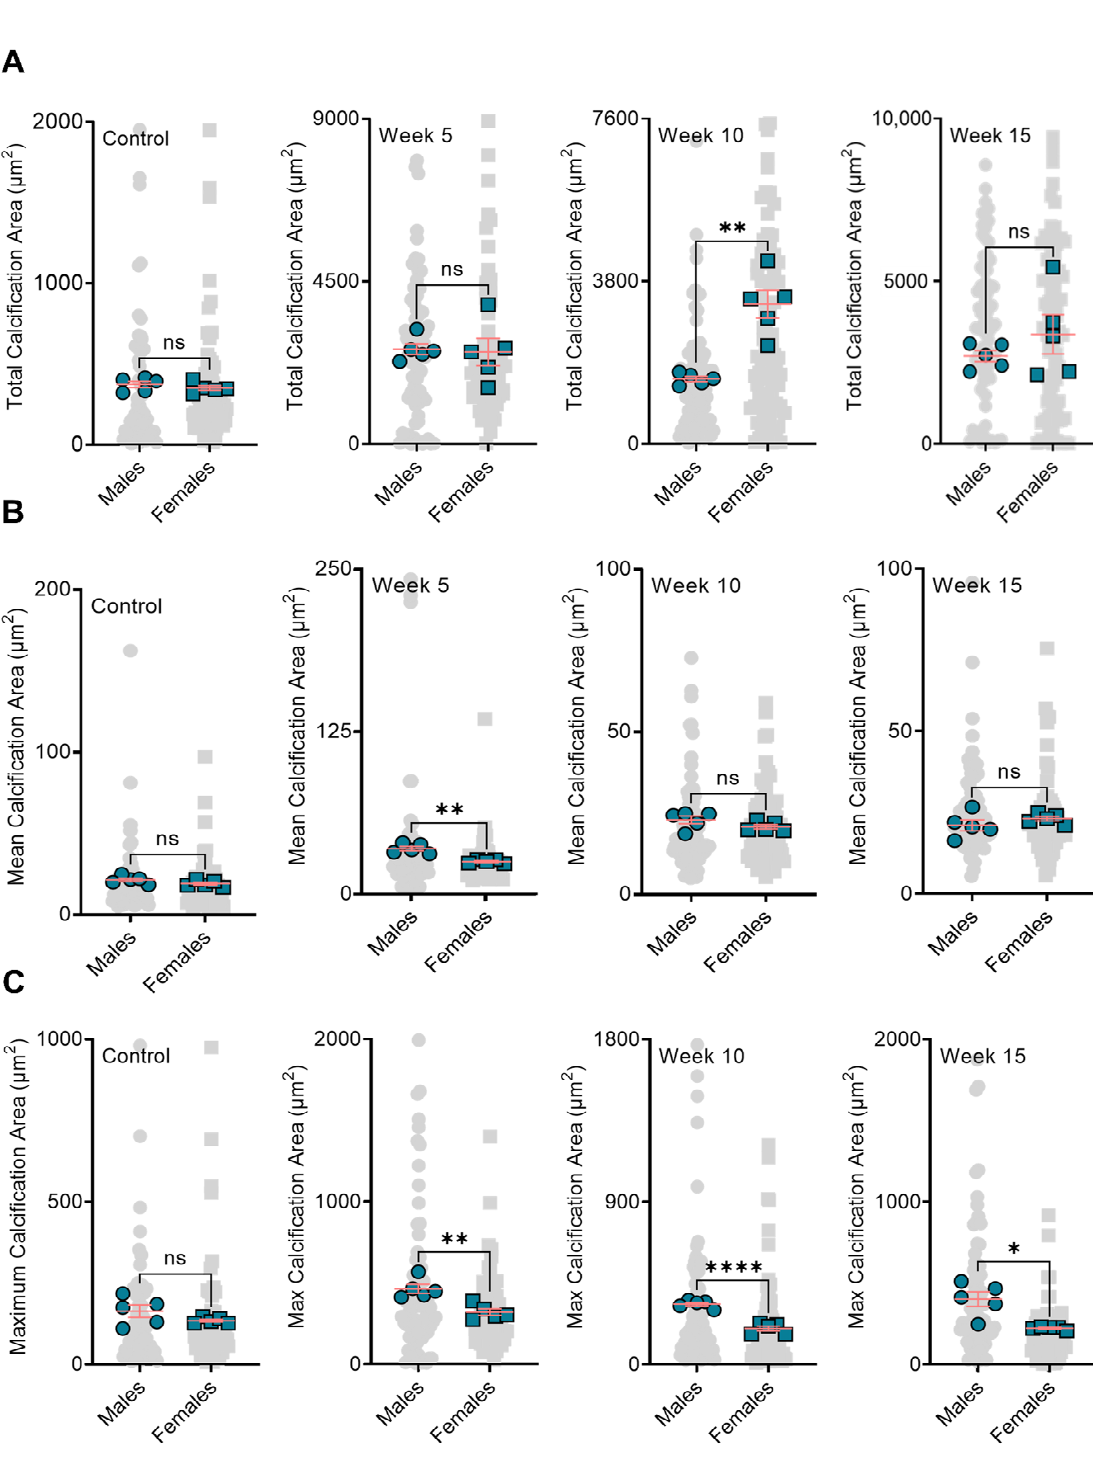
Figure 3. BiP treatment may affect the mineral morphology differently in male and female mouse model. Panel ( A ) is the comparison of total plaque calcification between male and female mice; Panel ( B ) is the comparison of mean calcification area between male and female mice; Panel ( C ) is the comparison of maximum calcification area between male and female mice. Note that gray points ( ● or ■ ) in the background represent technical replications, i.e., all calcifications measured across all mice, and green points ( ● or ■ ) represent the biological replications, i.e., the average value for each mouse. * p < 0.05, ** p ≤ 0.01, and **** p ≤ 0.0001, Student’s t -test. “ns” stands for not significant.